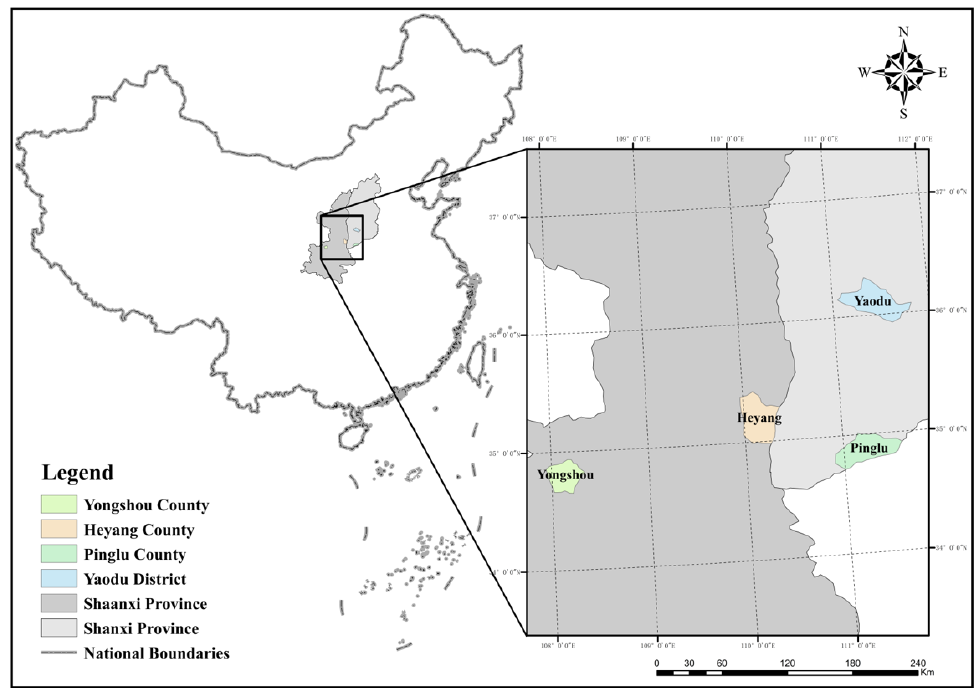
Figure 2 . Sample locations . Figure 2. Sample locations.